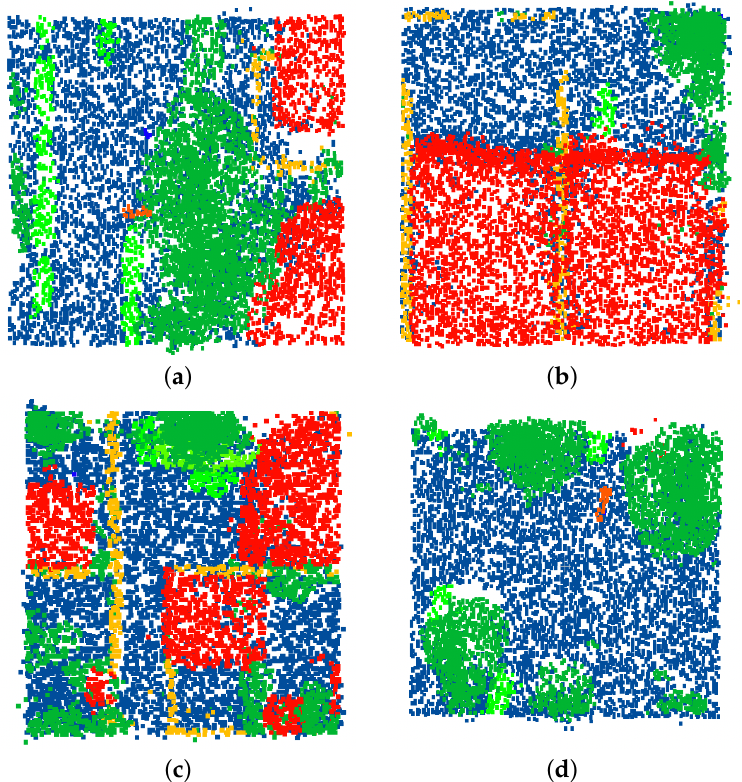
Figure 15. These images show examples of the scenes from Dataset 2. Dataset 2 contains the initial occluded input point clouds and our generated points. These have been combined and then run through a semantic segmentation network. Each scene has 18,882 total points with eight classes. Each point is labeled by object category: ground (blue), vegetation (dark green), power lines (yellow), poles (dark orange), buildings (red), fences (light orange), trucks (light green), cars (light green), unknown (dark